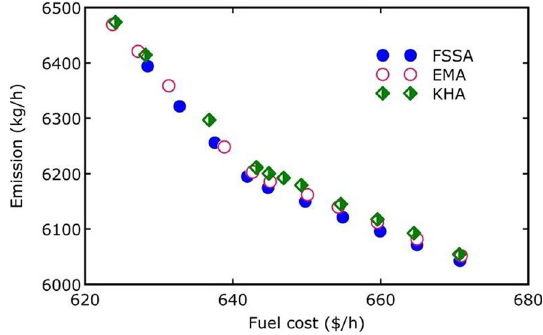
Fig. 6 POF curves obtained from various approaches